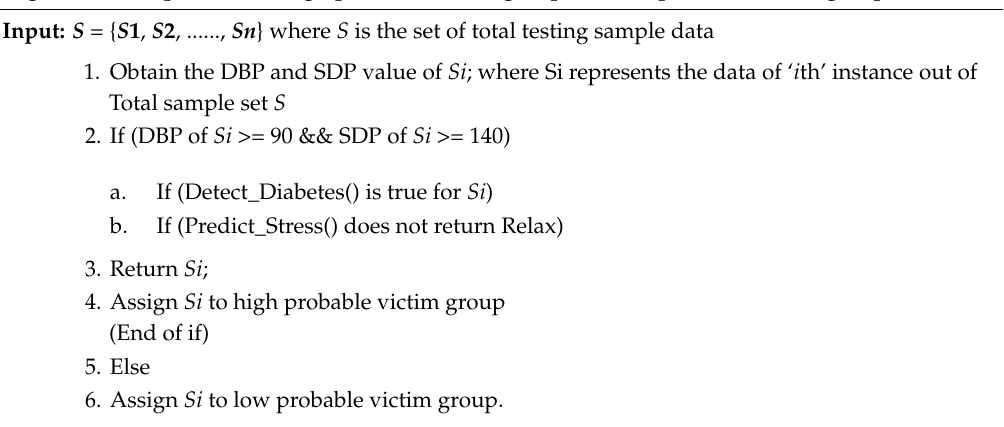
Algorithm 1: Separation of high probable victim group and low probable victim